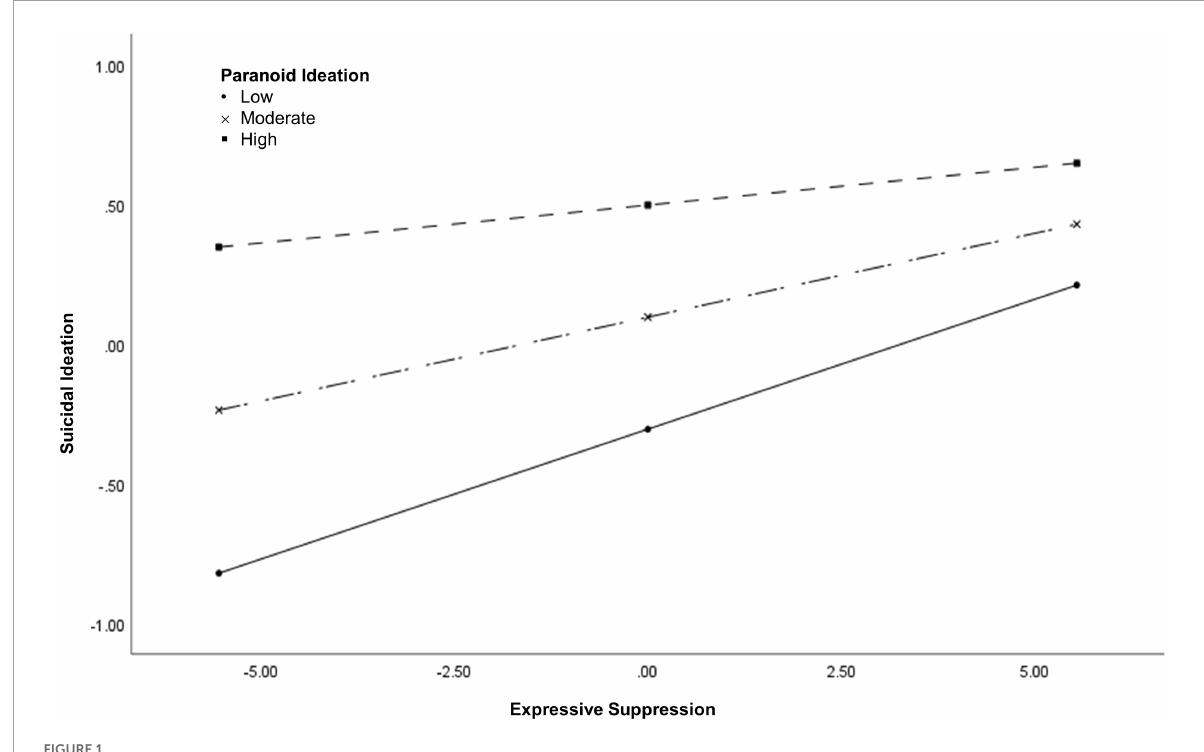
FIGURE1 The interaction between paranoid ideation and expressive